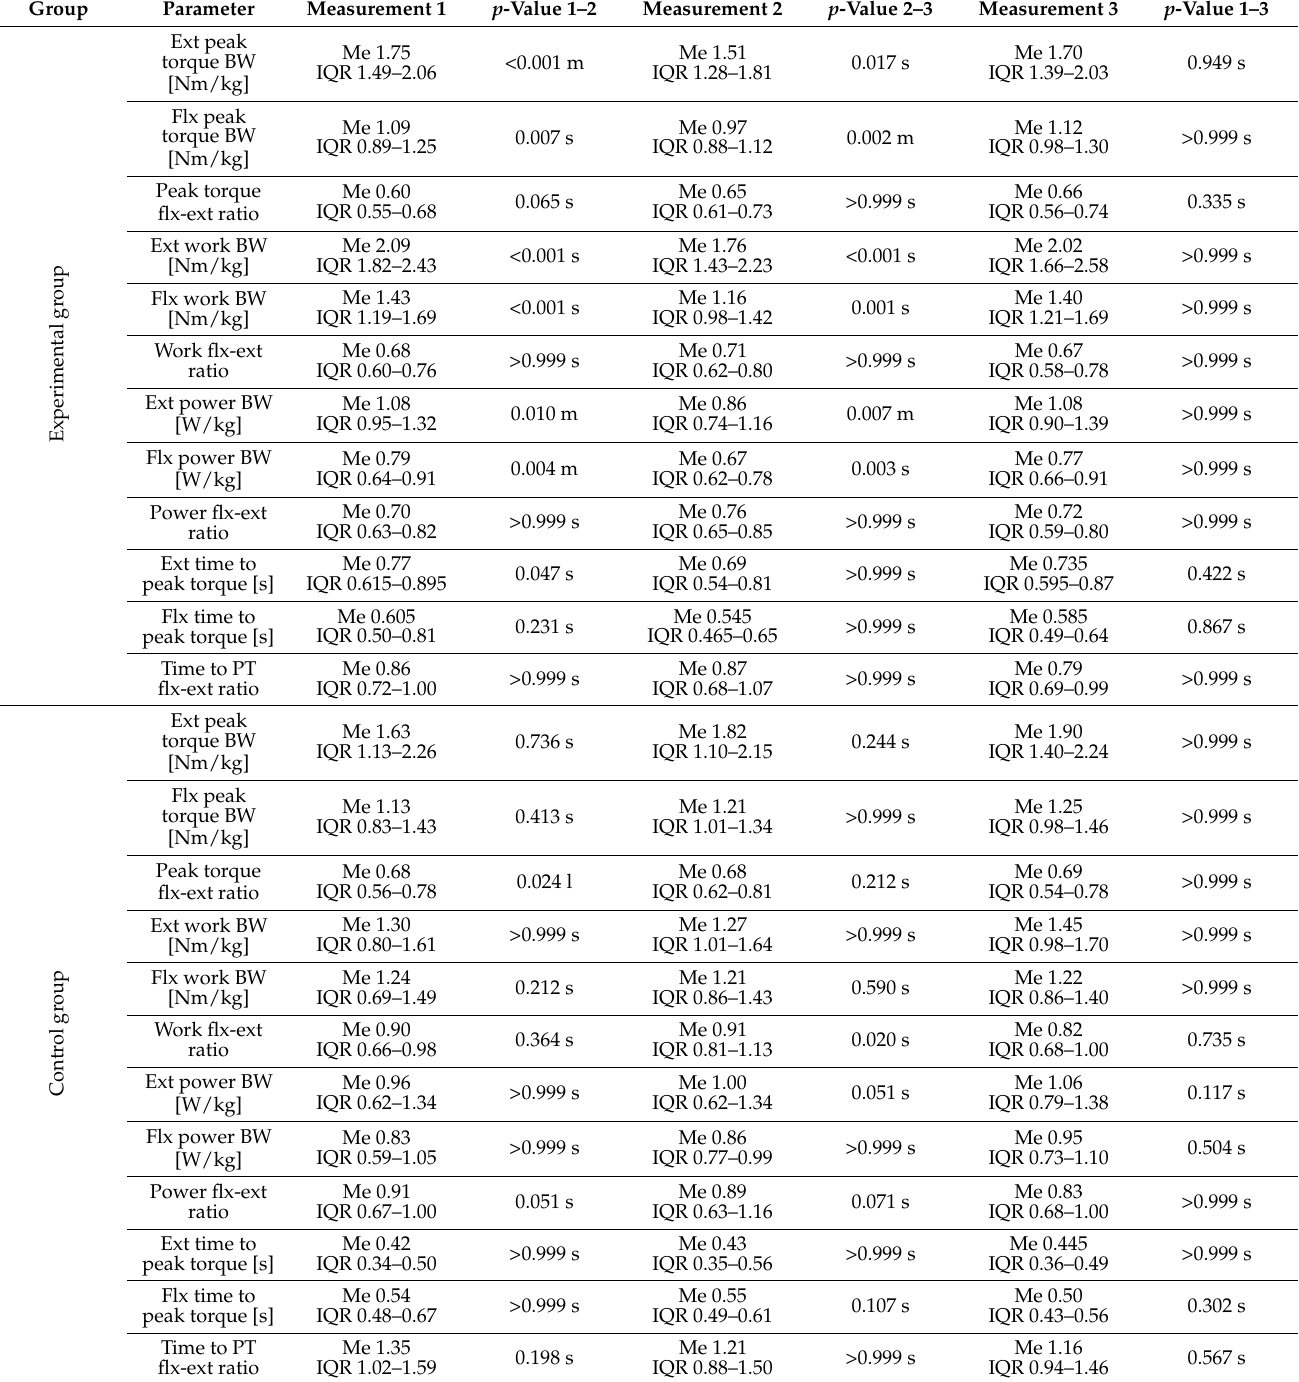
Table A1. Results of the measurement in the 60 ◦ /s test for the experimental and the control group, where: s—means small, m—medium and l—large effect size calculated by Cohen’s